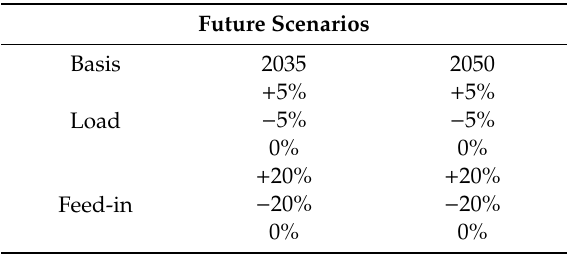
Table 3. Summary of future supply–load